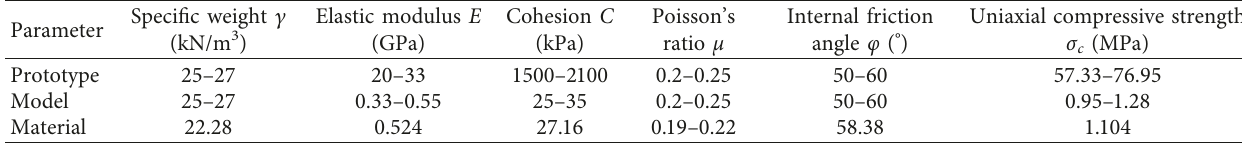
Table 2: Thickness and mechanical parameters of the prototype and model of the lining and middle partition wall. Initial support thickness Parameter